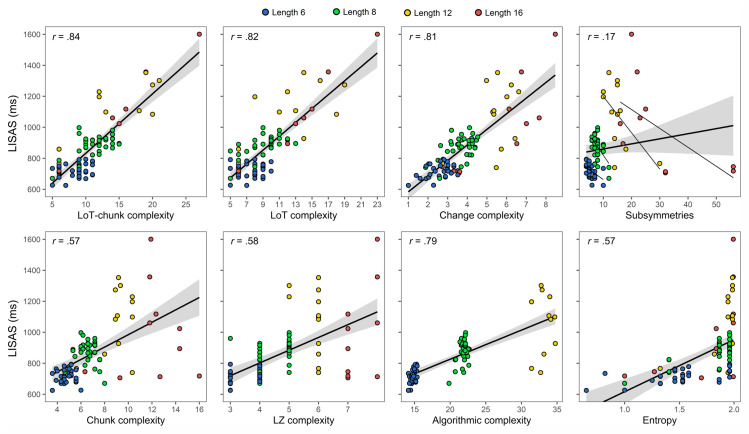
Linear regressions of average performance per sequence (LISAS, in ms) with eight different predictors of interest when combining data from experiments with auditory sequences of 4 different lengths.Each marker corresponds to one sequence. Sequences of different lengths are indicated by different markers only for illustration purposes (the length factor was not taken into account when computing the correlation coefficient, r). 16-items long sequences (as well as one 12-items sequence) could not be included in the regression with algorithmic complexity. Regressions lines for each sequence length were added in the subsymmetries plot, in order to illustrate the fact that negative correlations were observed when each length was considered separately. Note that the average performance data presented here does not take into account the effects of surprise, inter-subject, or inter-experiment variability.